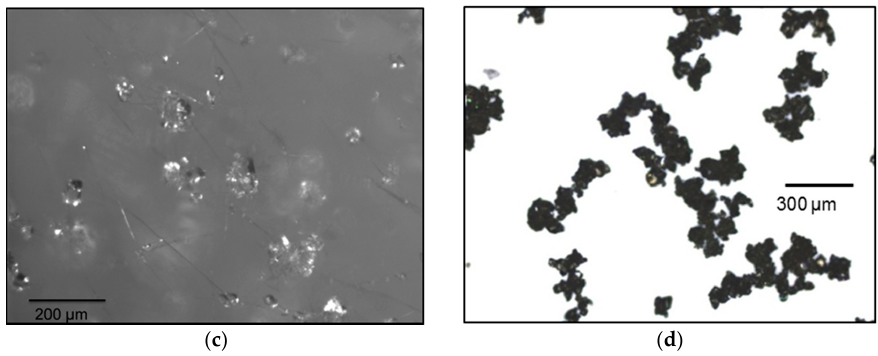
Figure 4. ( a ) Total counts and volume of water pumped in the vessel during antisolvent crystallization of piroxicam (2.5 mL/min water flow); ( b ) Evolution of the chord length distribution during the experiment; ( c ) particle vision and measurement (PVM) image of the crystals during nucleation and growth. Needle-shape crystals were identified as piroxicam form II; ( d ) Crystals after filtration and drying. Form II was not detected at the end of the experiment.